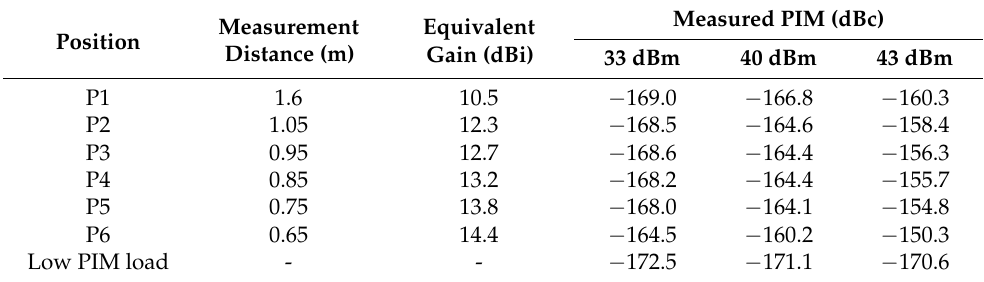
Table 1. Measured results of chamber A at 900 MHz.